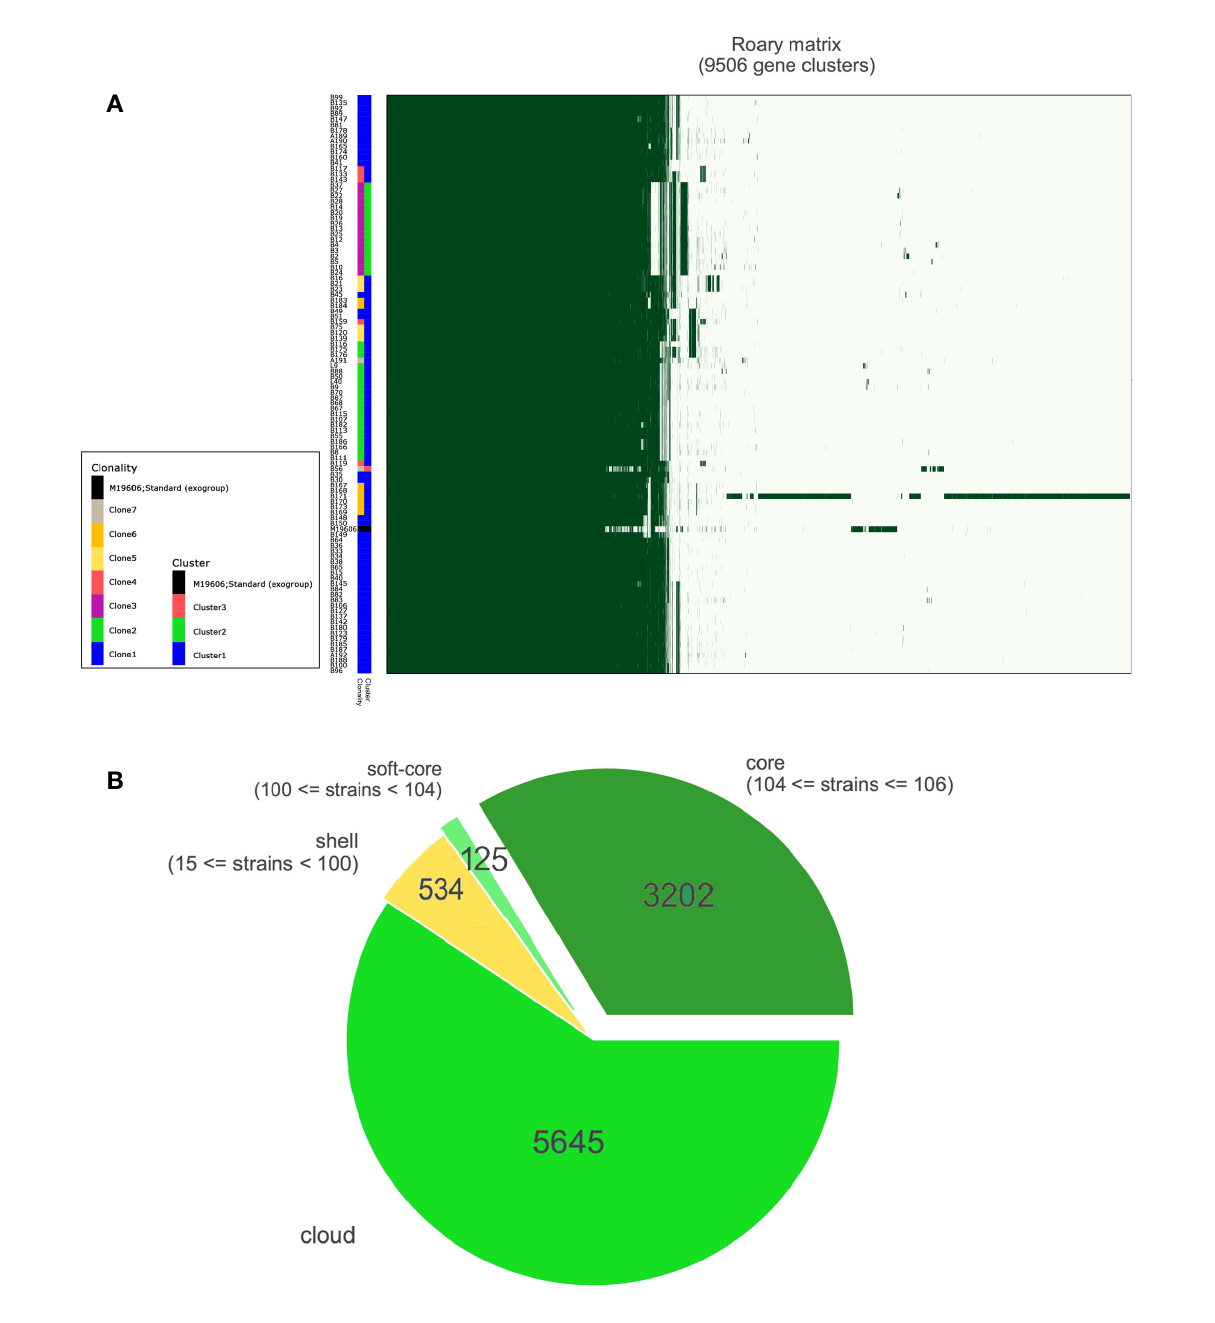
FIGURE 2 | Results of pan-genomic analysis. (A) Matrix with the presence and absence of core and accessory genes. A total of 9,506 genes were clustered and annotated with different colors. different clonalities based on SNP distance and different clusters based on bayesian classi fi cation. (B) Pie chart shows different kinds of accessory genes; the number of core genes was